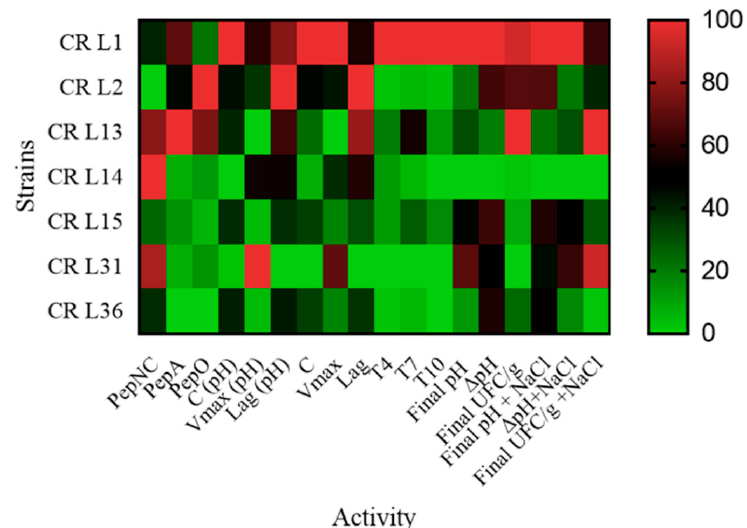
Figure 6. Heatmap based on lactic acid bacteria strains technological features assessed in the screening: peptidase activities (general aminopeptidase (PepNC), glutamyl aminopeptidase (PepA), and endopeptidase (PepO)); acidification and growth parameters (C, Vmax, and Lag) in an MRS medium; pH; Δ pH (difference between final and initial pH); cell concentrations (CFU/g) and Δ cell concentrations (difference between final and initial cell concentration; and CFU/g) in doughs with NaCl addition and without NaCl addition; percentage of bacterial strains at the end of 4th (T4), 7th (T7), and 10th (T10) backslopping in the robustness test. The values of the activities were standardized to range from 0 to 100. Colors correspond to normalized mean data levels from low (green) to high